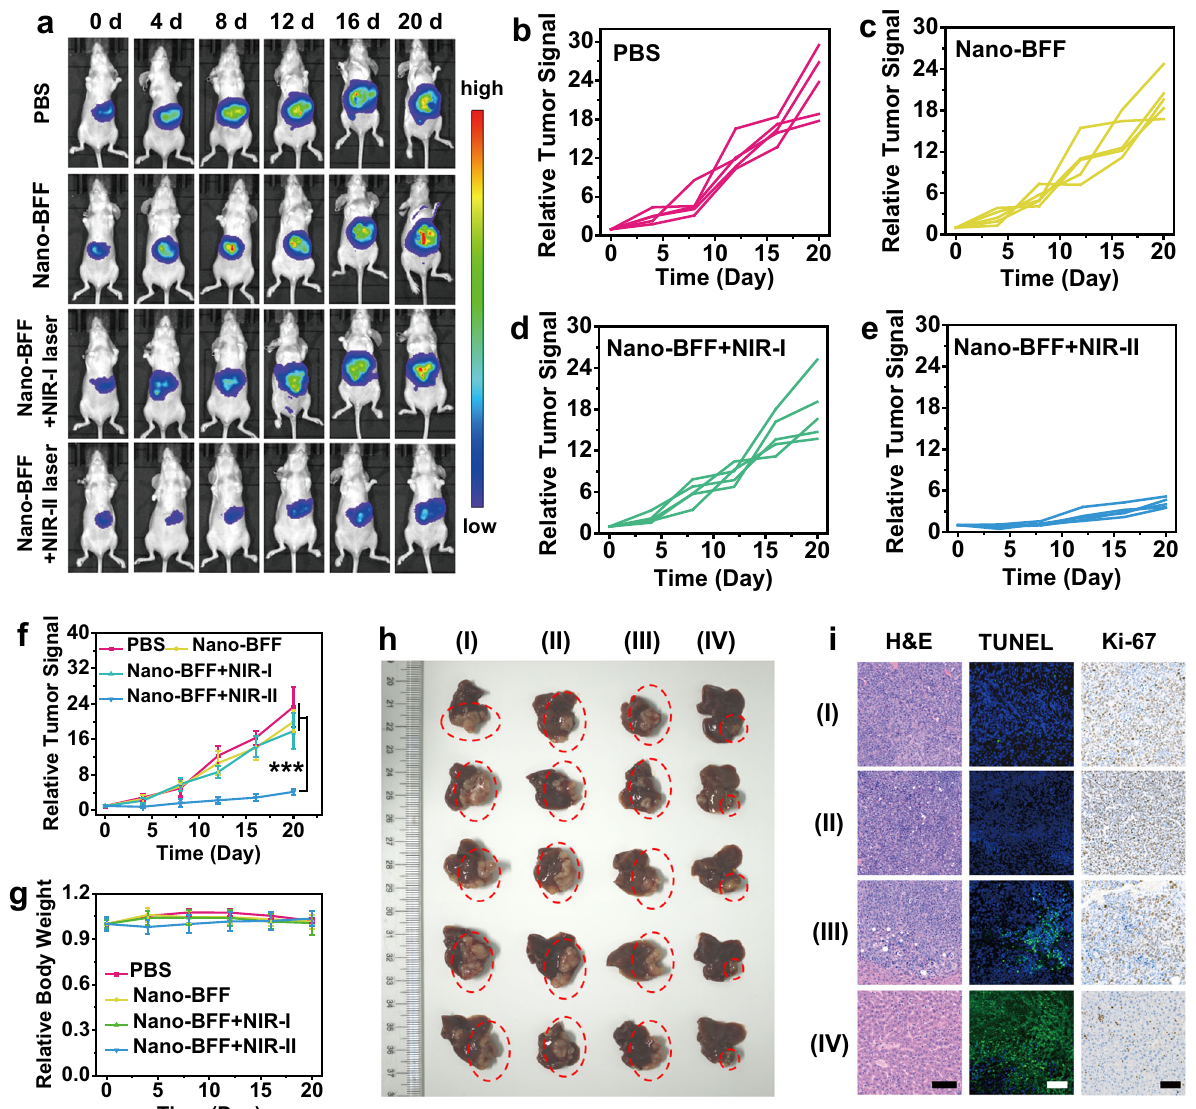
Fig. 7 In vivo antitumor performance of Nano-BFF toward orthotopic HCC. a Bioluminescence images of the mice treated with PBS, Nano-BFF, Nano-BFF + NIR-I laser, and Nano-BFF + NIR-II laser on days 0, 4, 8, 12, 16, and 20, respectively ( n = 5 biologically independent samples). b – e Relative orthotopic liver tumor luminescence levels of mice after various treatments, including b PBS, c Nano-BFF, d Nano-BFF + NIR-I laser, and e Nano-BFF + NIR-II laser. f Relative orthotopic liver tumor luminescence levels of the mice, and g body weight variations of the mice in various treatment groups within 20 days ( n = 5 biologically independent samples). Scale bars: 100 μ m. Data are presented as mean values ± SD. p >0.05; * p < 0.05; ** p < 0.01; *** p < 0.001, analyzed by Student ’ s two- sided test. h Photographs of liver tissues in each treatment group, where the orthotopic tumor tissues were highlighted with red dotted circles. i Histological images of the orthotopic liver tumor tissues using H&E, TUNEL, and Ki-67 staining assays (I: PBS; II: Nano-BFF; III: Nano-BFF + NIR-I laser; IV: Nano-BFF + NIR-II laser). A representative image of three biological replicates from each group is